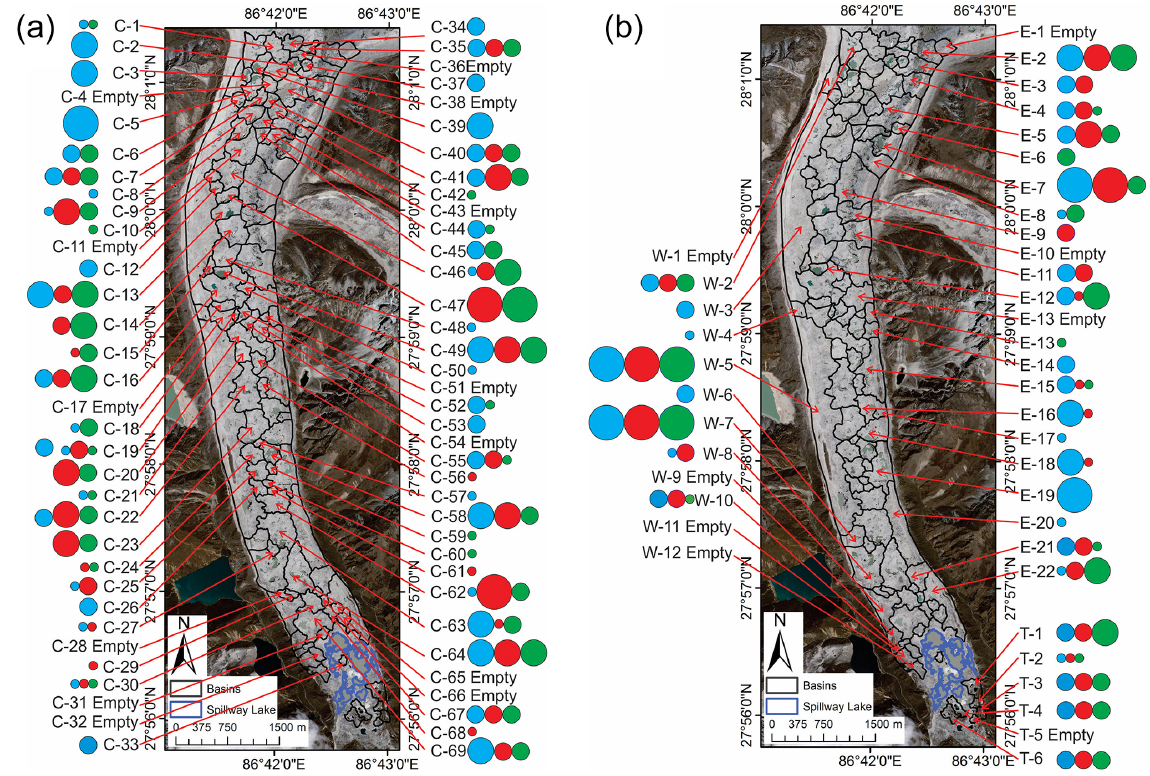
Figure 10. Surface drainage basins and lake area changes: (a) the central part of the glacier and (b) the lateral margins and terminal zone. Lake areas are shown for 2010 (blue), 2012 (red), and 2015 (green) in four categories: < 1000m 2 (small circles), 1000–5000m 2 (medium circles), 5000–10000m 2 (large circles), and > 10000m 2 (largest circles). Missing coloured circles indicate empty basins in that